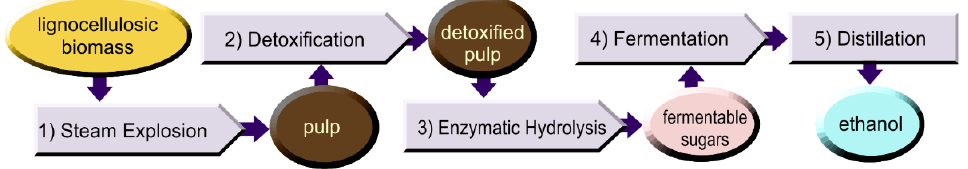
Figure 2. Scheme of the conversion of lignocellulosic biomass into bioethanol.